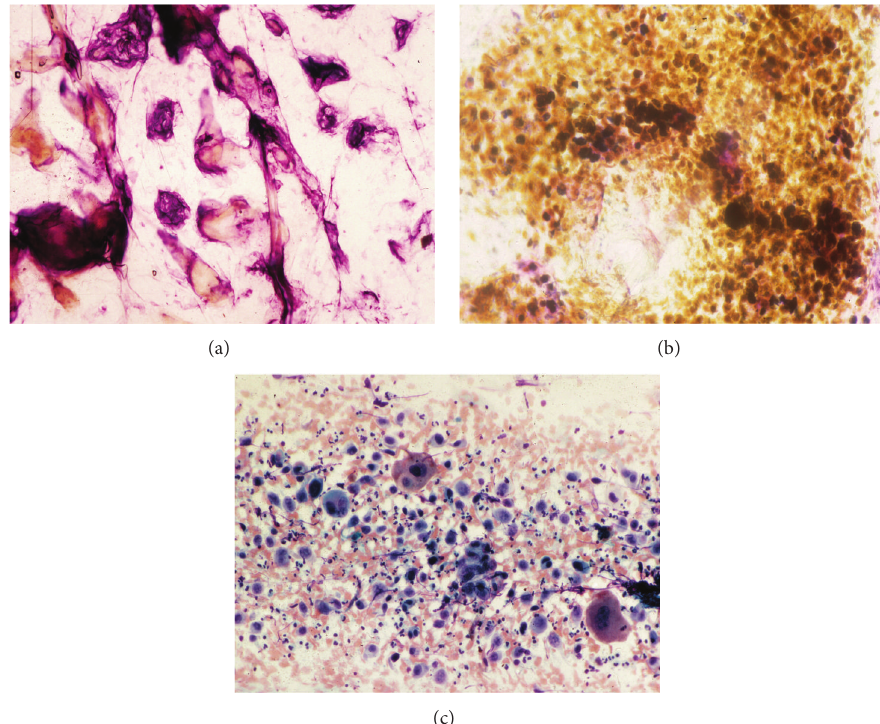
Figure 8: Epithelial neoplasms. (a) Seborrheic keratosis. (b) Malignant melanoma. (c) Carcinoma of the genital